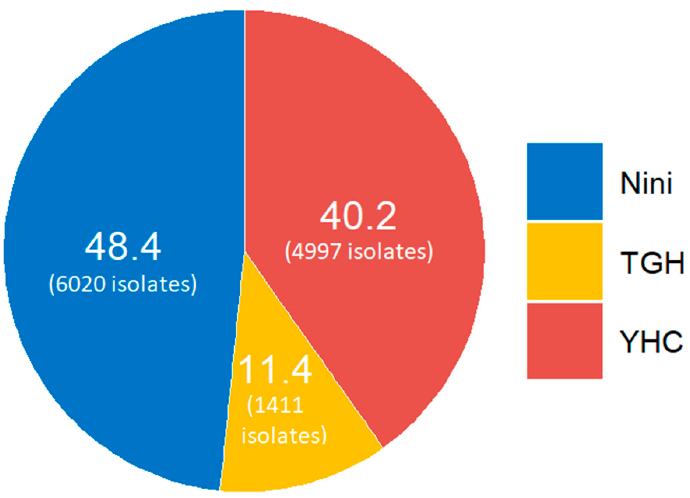
Figure 3. Origin of the isolates (%).